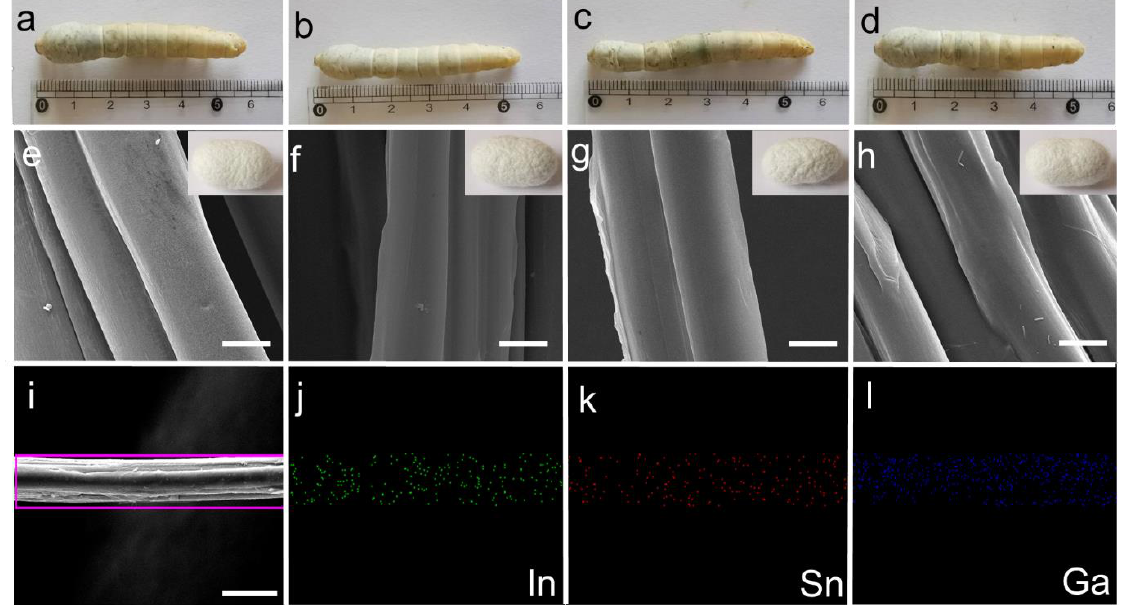
Figure 3. ( a – d ) Photographs of the mature larvae and vignettes of cocoons from the silkworms fed with different diets in the order of Control, LM@NaAlg-1, LM@NaAlg-2, and LM@NaAlg-3, showing no observable difference. ( e – h ) SEM images showing the morphology of the degummed silk fibers corresponding to the cocoons shown in ( a – d ). ( i – l ) EDS mapping of the selected area of the silk fibers. The scale bar is 10 μm.